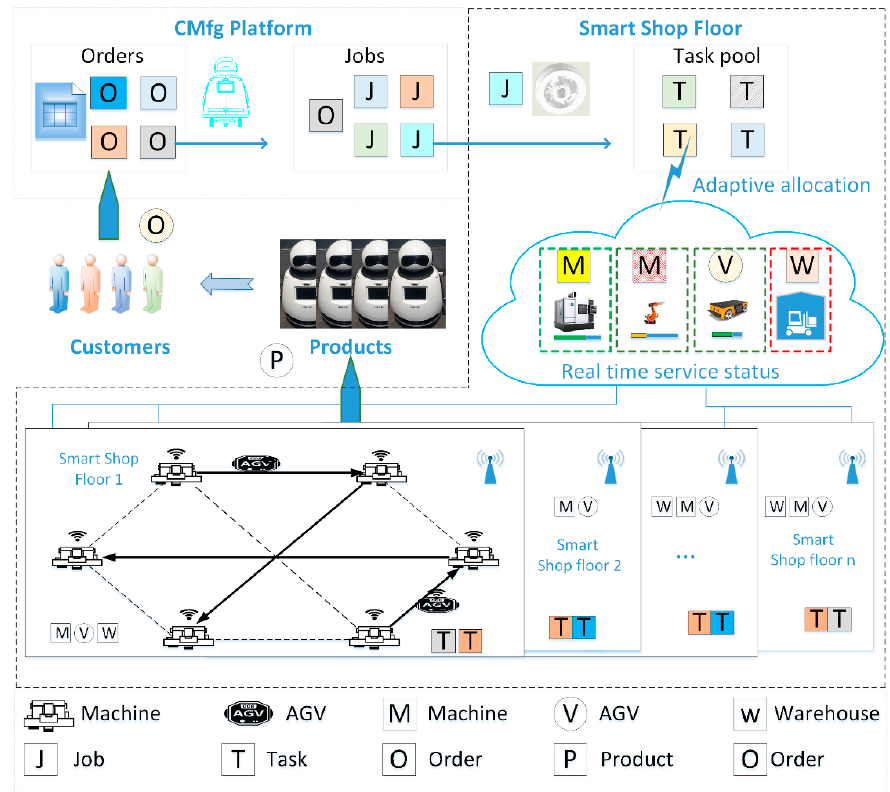
Figure 1. Scenario description of the real-time manufacturing resources allocation (RTMSA) problem.